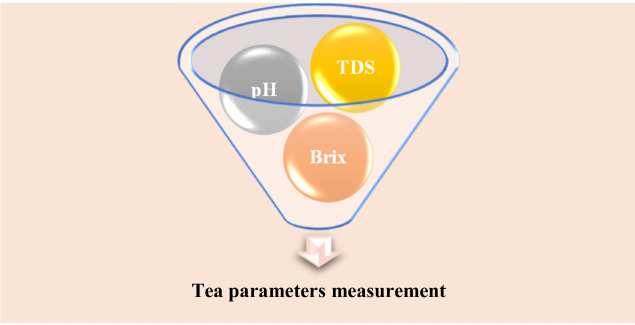
Figure 4. Electrically transformed tea